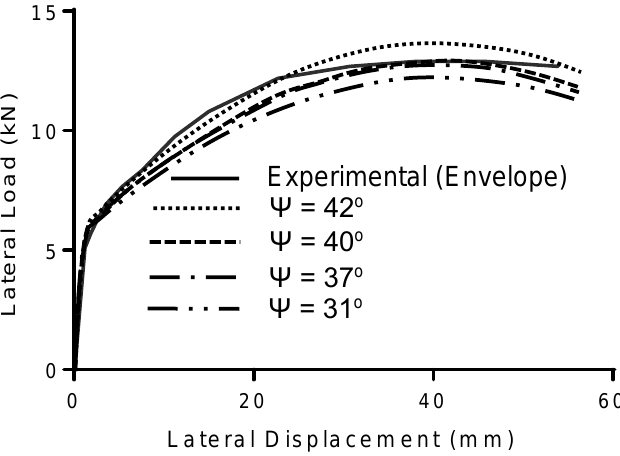
Figure 11. Joint J1 load-displacement response based on dilation angle variation.